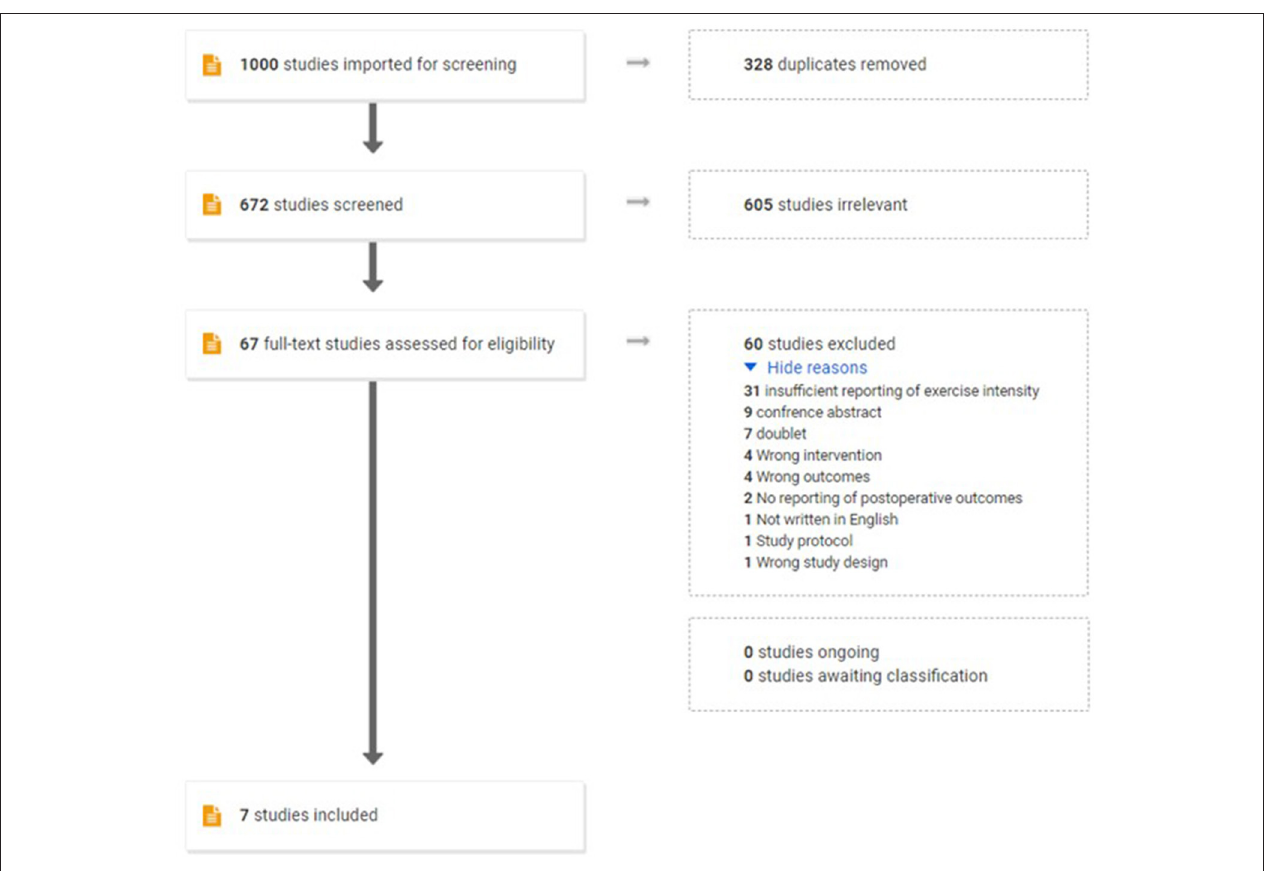
FIGURE 2 | Flow chart of the study selection